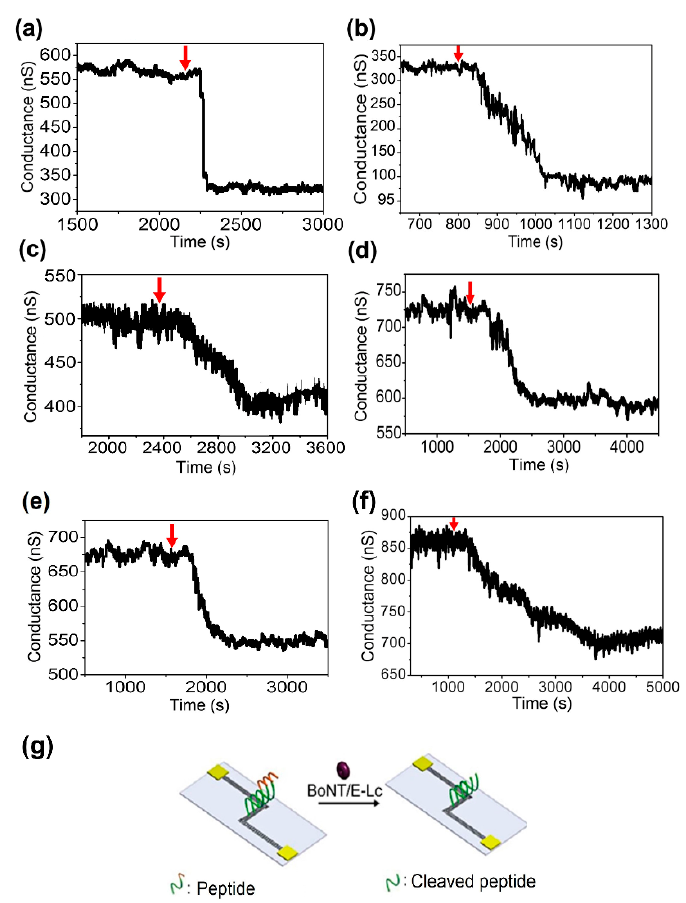
Figure 4. Real-time monitoring of the interaction between specific peptides and BoNT/E-Lc. Measurement of electrical signal changes owing to specific reaction between varying concentrations of BoNT/E-Lc and unique peptides. ( a ) 5 nM BoNT/E-Lc; ( b ) 3 nM BoNT/E-Lc; ( c ) 1 nM BoNT/E-Lc; ( d ) 0.3 nM BoNT/E-Lc; ( e ) 0.1 nM BoNT/E-Lc; ( f ) 60 pM BoNT/E-Lc; ( g ) Schematic of the cleavage of the 29-mer peptide by BoNT/E-Lc. The red arrow in the figure indicates the injection of the target molecules.